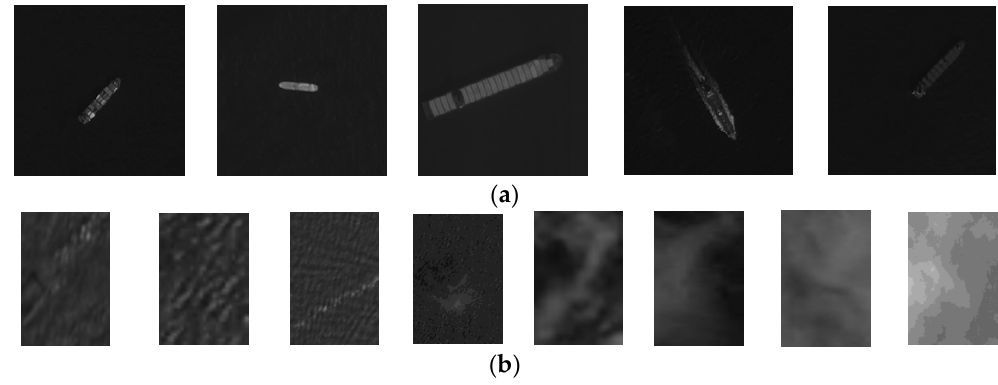
Figure 13. Some sample slices. ( a ) Positive samples; and ( b ) some typical negative samples.